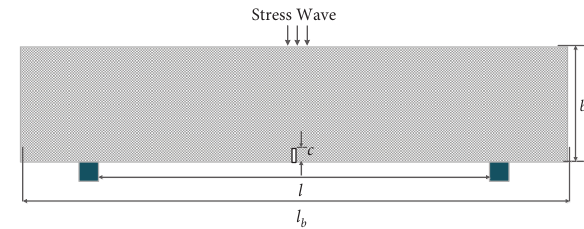
Figure 1: The numerical